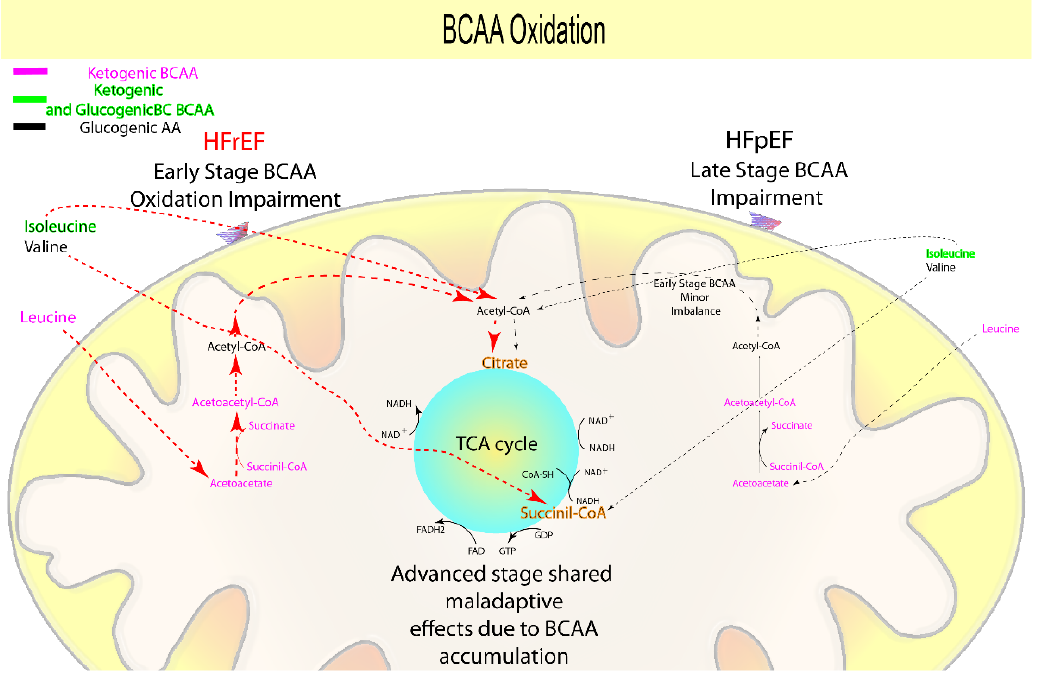
Figure 4. Suggested prognostic metabolites involved in BCAA metabolism: Accumulation of BCAAs (valine, leucine, isoleucine) or their catabolites may be suitable as predictors of early HFrEF, which is compatible with the neurohormonal and direct cardiac damage origins of the disease, as demonstrated by animal models. However, as the disease progresses, both HFpEF and HFrEF accumulate BCAA, causing maladaptive effects, which also supports the participation of the microvascular dysfunction in addition to the previously indicated neurohormonal-mediated and direct cardiac damage origin of the disease.